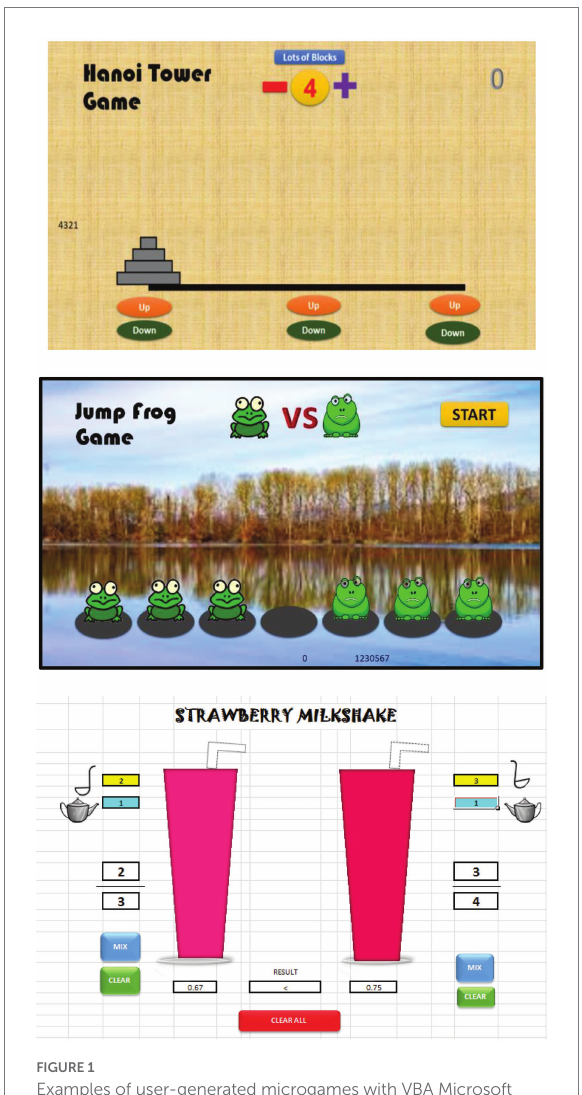
FIGURE 1 Examples of user-generated microgames with VBA Microsoft